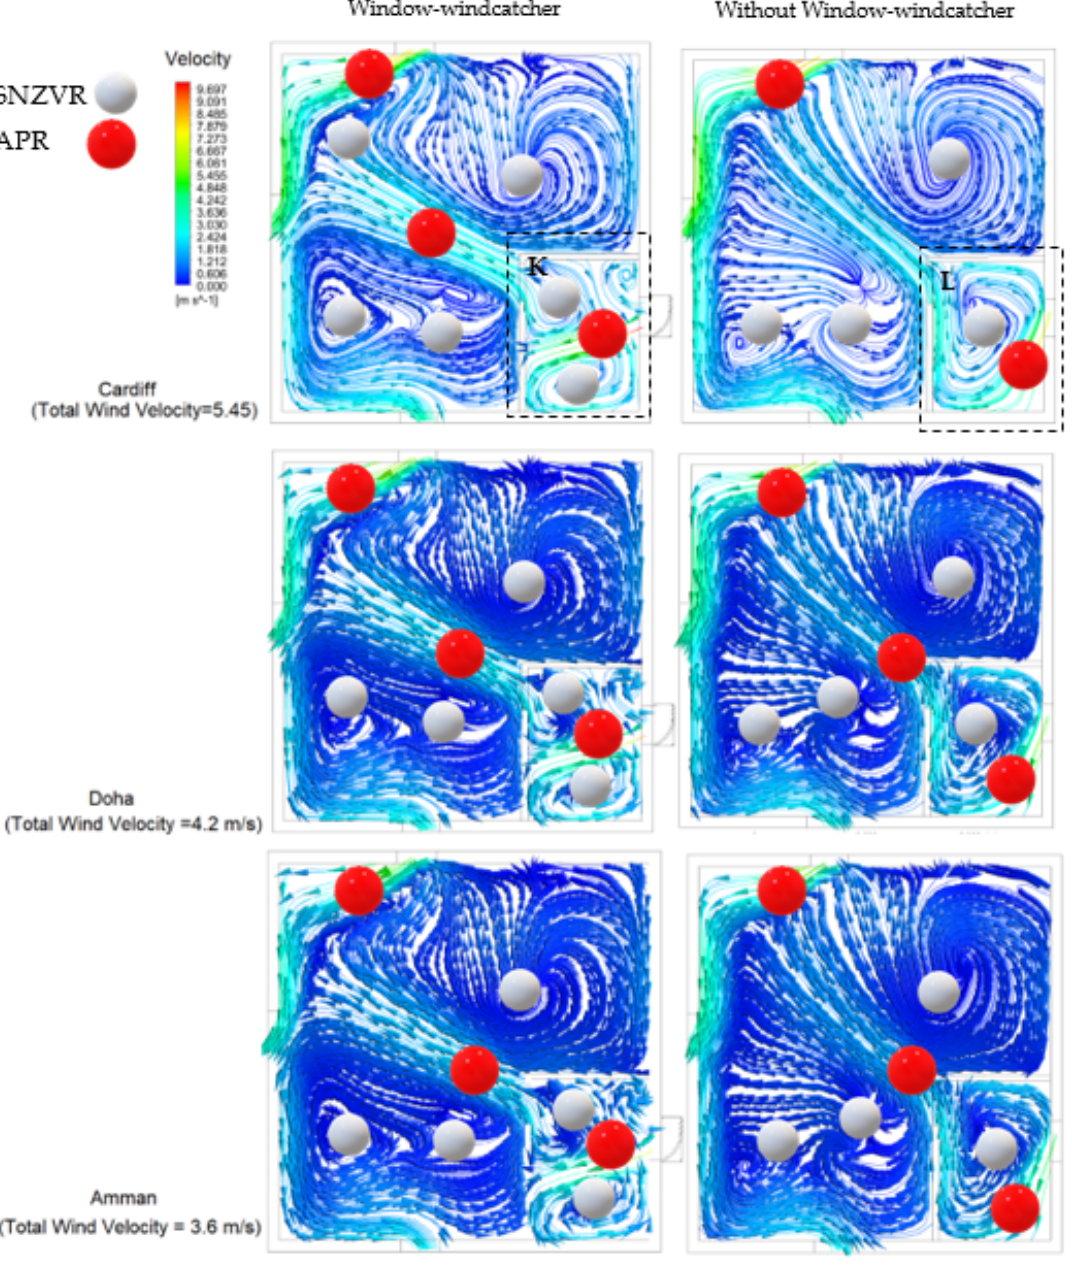
Figure 13. Streamlines at the 1 m interior plane (APR: Air purifiers region, SNZVR: safe near-zero- velocity regions).